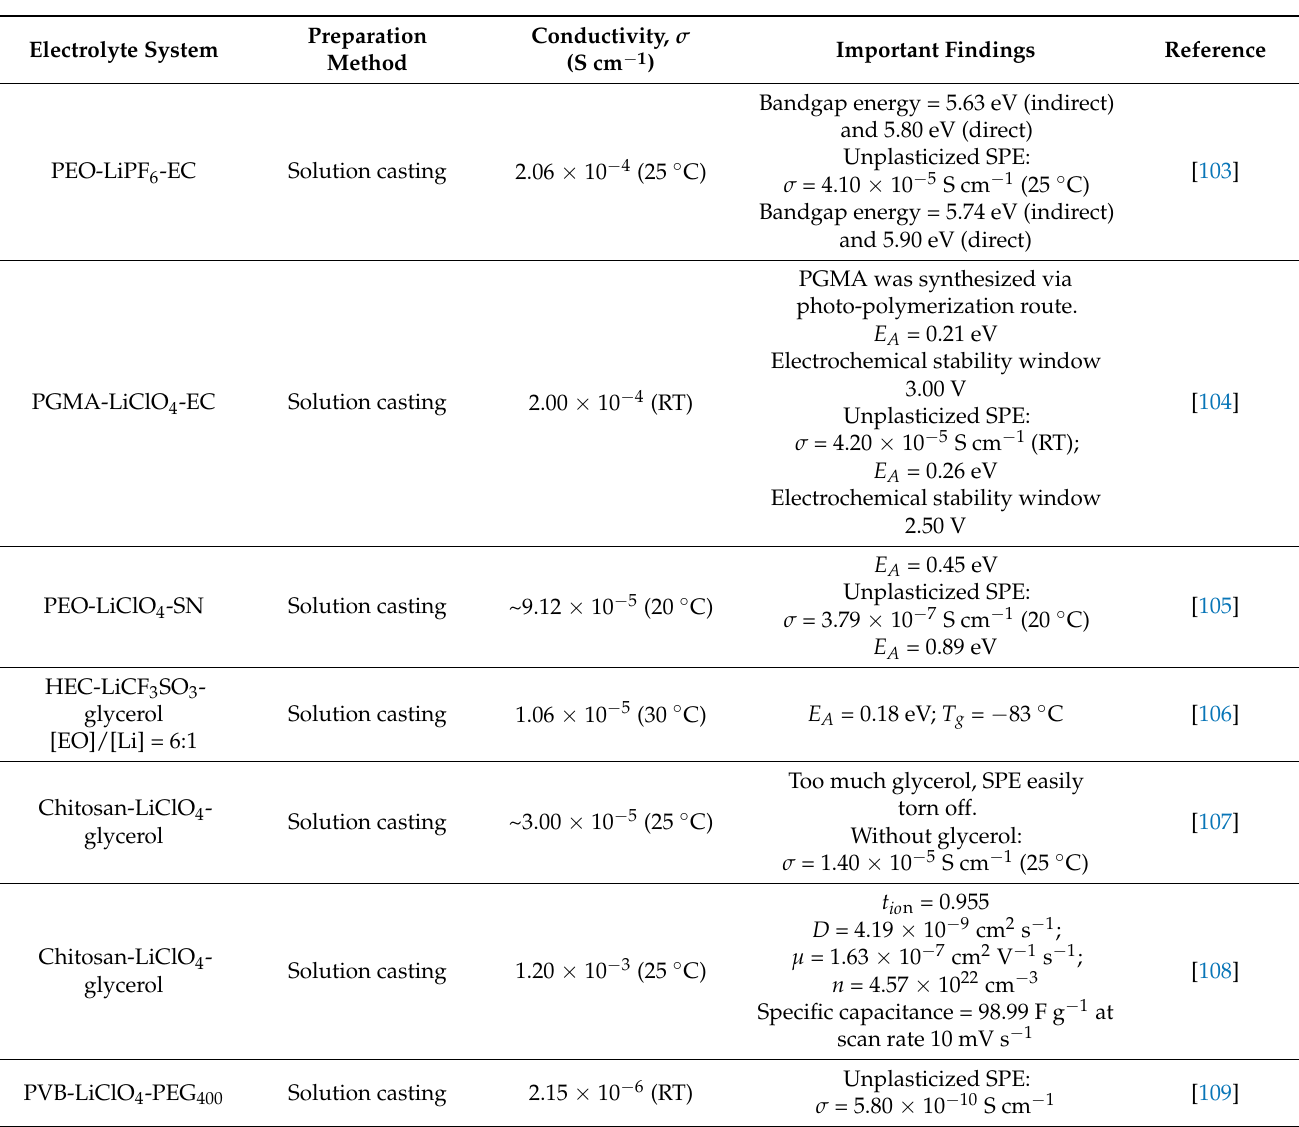
Table 6. Examples of plasticized SPEs systems found in the